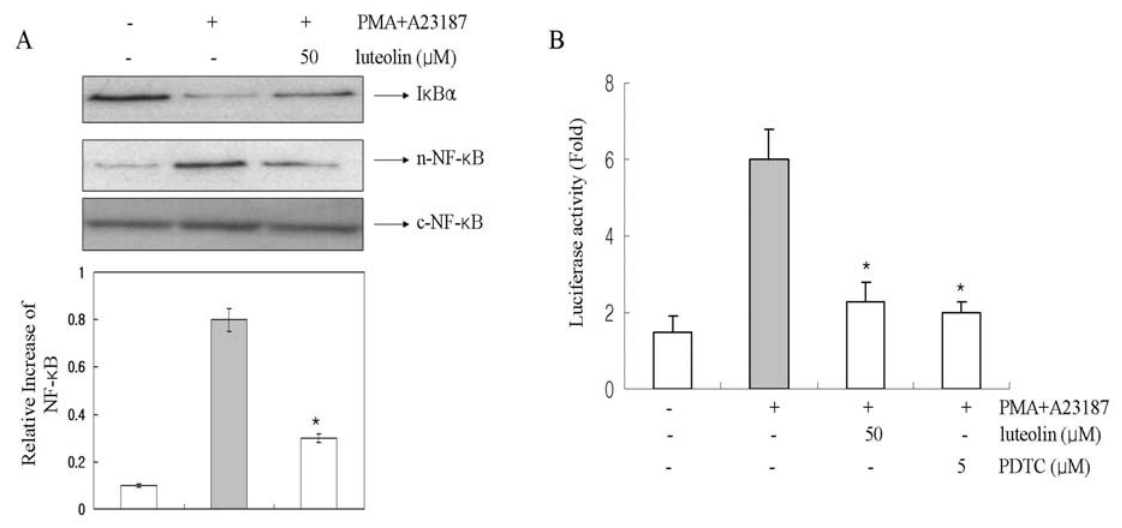
Cells were pretreated with luteolin for 1 h prior to PMA (50 nM) and A23187 (1 μ M) stimulation. (A) I κ B degradation and NF- κ B translocation were assayed by Western blot (n-NF- κ B, nucleus NF- κ B; c-NF- κ B, cytoplasmic NF- κ B). (B) For NF- κ B luciferase assay, cells were